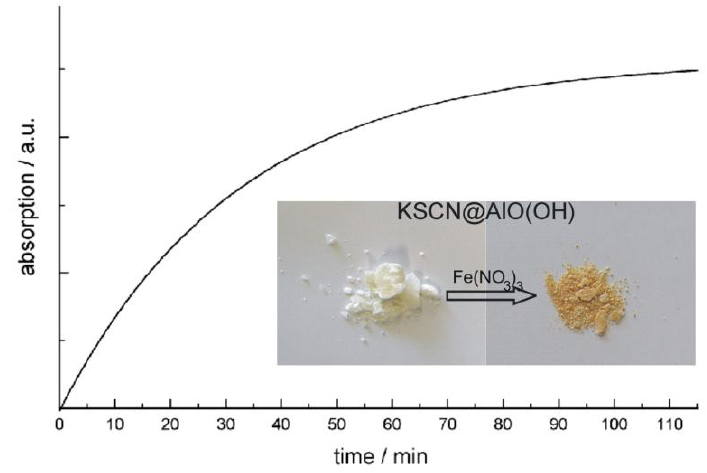
Figure 15. Photos of KSCN@AlO(OH) before and after reaction with Fe(NO time-dependent increase of Fe(SCN) reproduction from